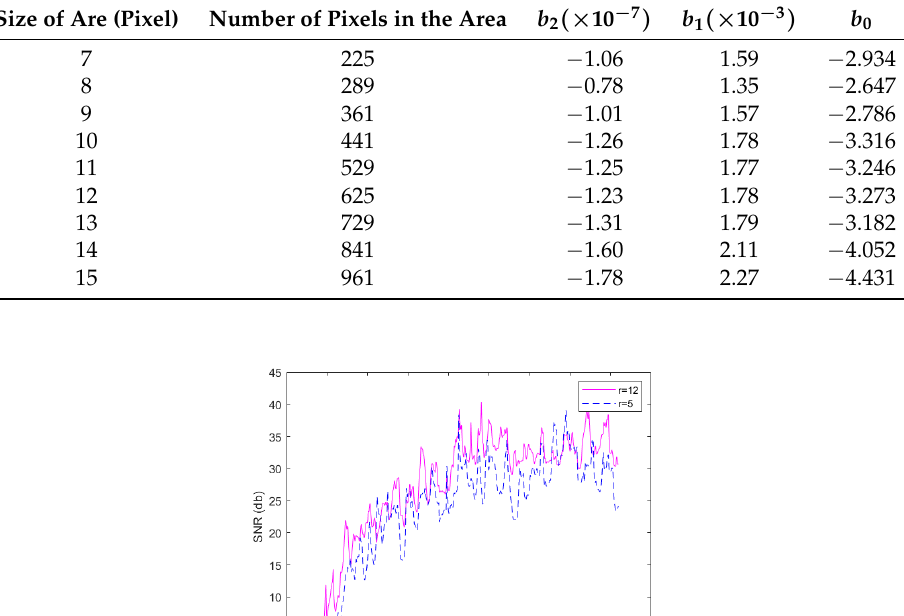
Table 2. The values of b 2 , b 1 , b 0 of LFSD for different values of r , for the selected pixel of the dish.